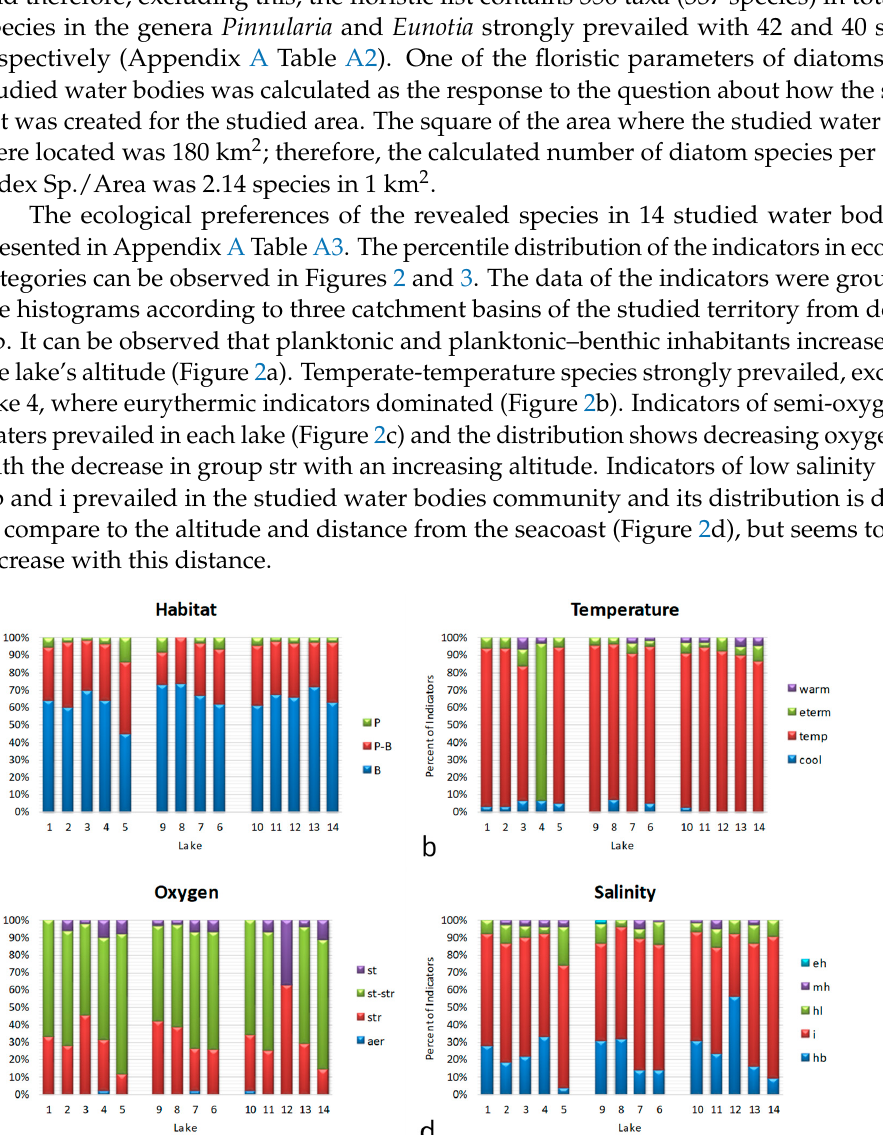
Figure 3. Bioindicator distributions in the 14 studied water bodies: ( a ) pH (alb—alkalibiontes; alf— alkaliphiles, ind—indi ff erent; acf—acidophiles; acb—acidobiontes); ( b ) nutrition type (ats—nitro- gen autotrophic taxa tolerating very small concentrations of organically bound nitrogen; ate—nitro- gen autotrophic taxa tolerating elevated concentrations of organically bound nitrogen; hne—facul- tative nitrogen heterotrophic taxa needing periodically elevated concentrations of organically bound nitrogen; hce—obligate nitrogen heterotrophic taxa needing continuously elevated concen- trations of organically bound nitrogen); ( c ) trophic state (ot—oligotraphentic; om—